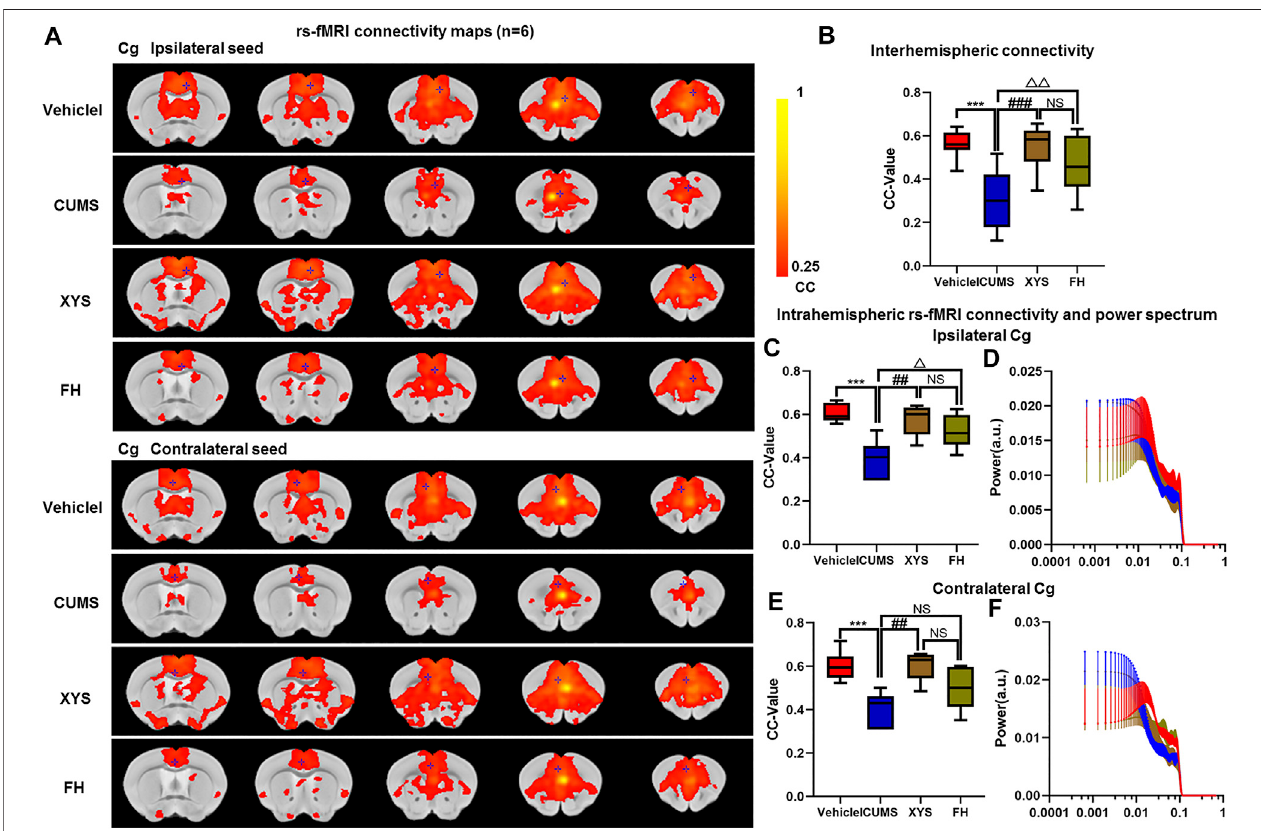
FIGURE 6 | Effect of Xiaoyaosan on brain functional connectivity in depressive-like mice induced by chronic stress. (A, B) Rs-fMRI connectivity maps of Cg in four groups of mice (A) , corresponding quanti fi cation of interhemispheric connectivity (B) . (B – E) Quanti fi cation of intrahemispheric rs-fMRI connectivity (C, E) and the respective power spectrum (D, F) of ipsilateral and contralateral Cg in four groups of mice. The data are presented as mean ± SEM. One-way ANOVA followed by Bonferroni ’ s posthoc test;*** p < 0.001,CUMSgroupvs.Vehiclegroup;## p < 0.01and### p < 0.001,CUMSgroupvs.XYSgroup; △ p < 0.05, △△ p < 0.01,CUMS group vs. FH group; error bars indicate mean ±